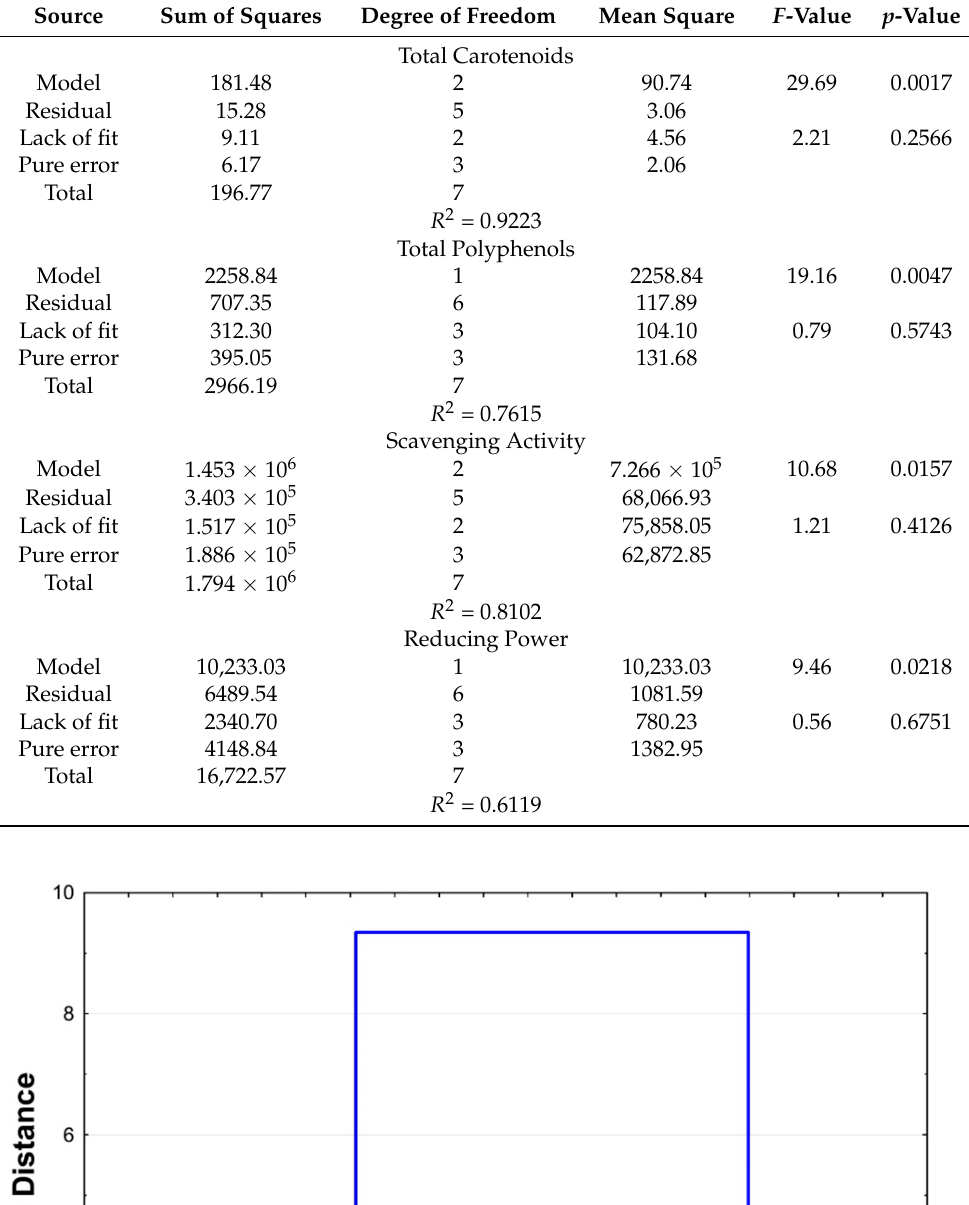
Table 5. Analysis of variance (ANOVA) of the modelled responses for ethanol + acetone.